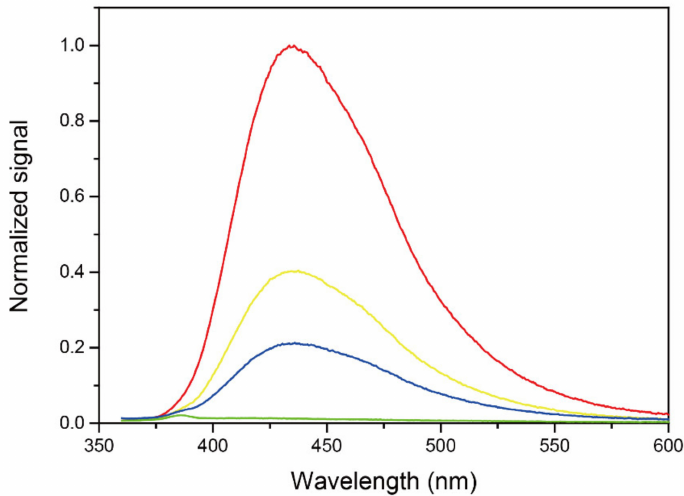
Figure 6. Feasibility verification and signal amplification. Fluorescent spectrum of S. aureus (3.76 × 10 7 CFU/mL) detected by Td − bCDs (red line), Td1 − MBs and Apt2 − bCDs (bright yellow line), naked Apt1 − MBs and bCDs (blue line), and blank control without S. aureus (green